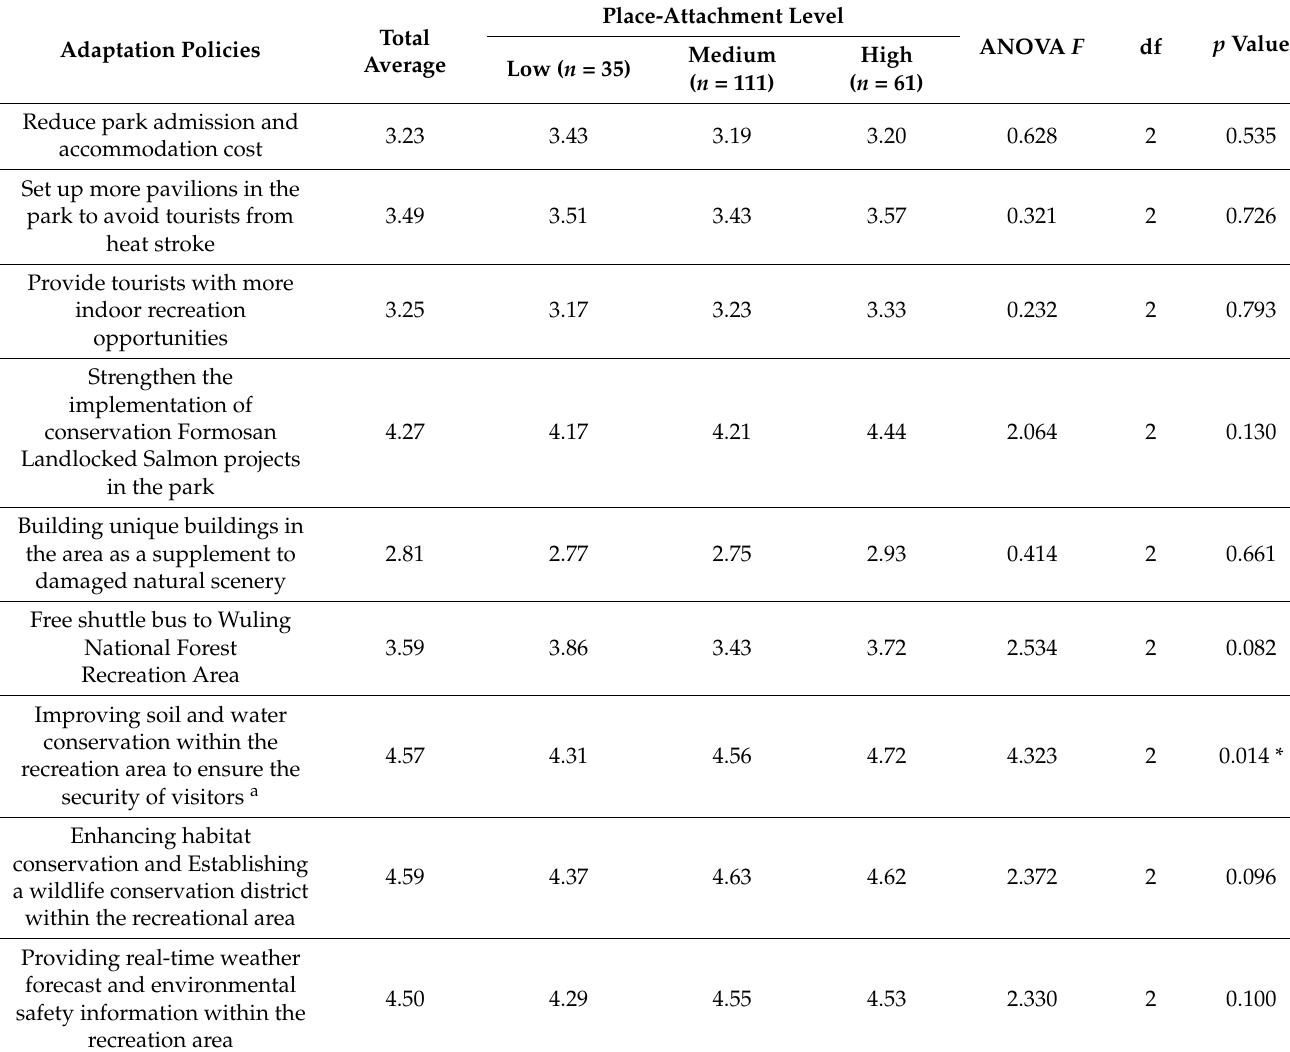
Table 10. Attitudes toward adaptational policies based on place-attachment